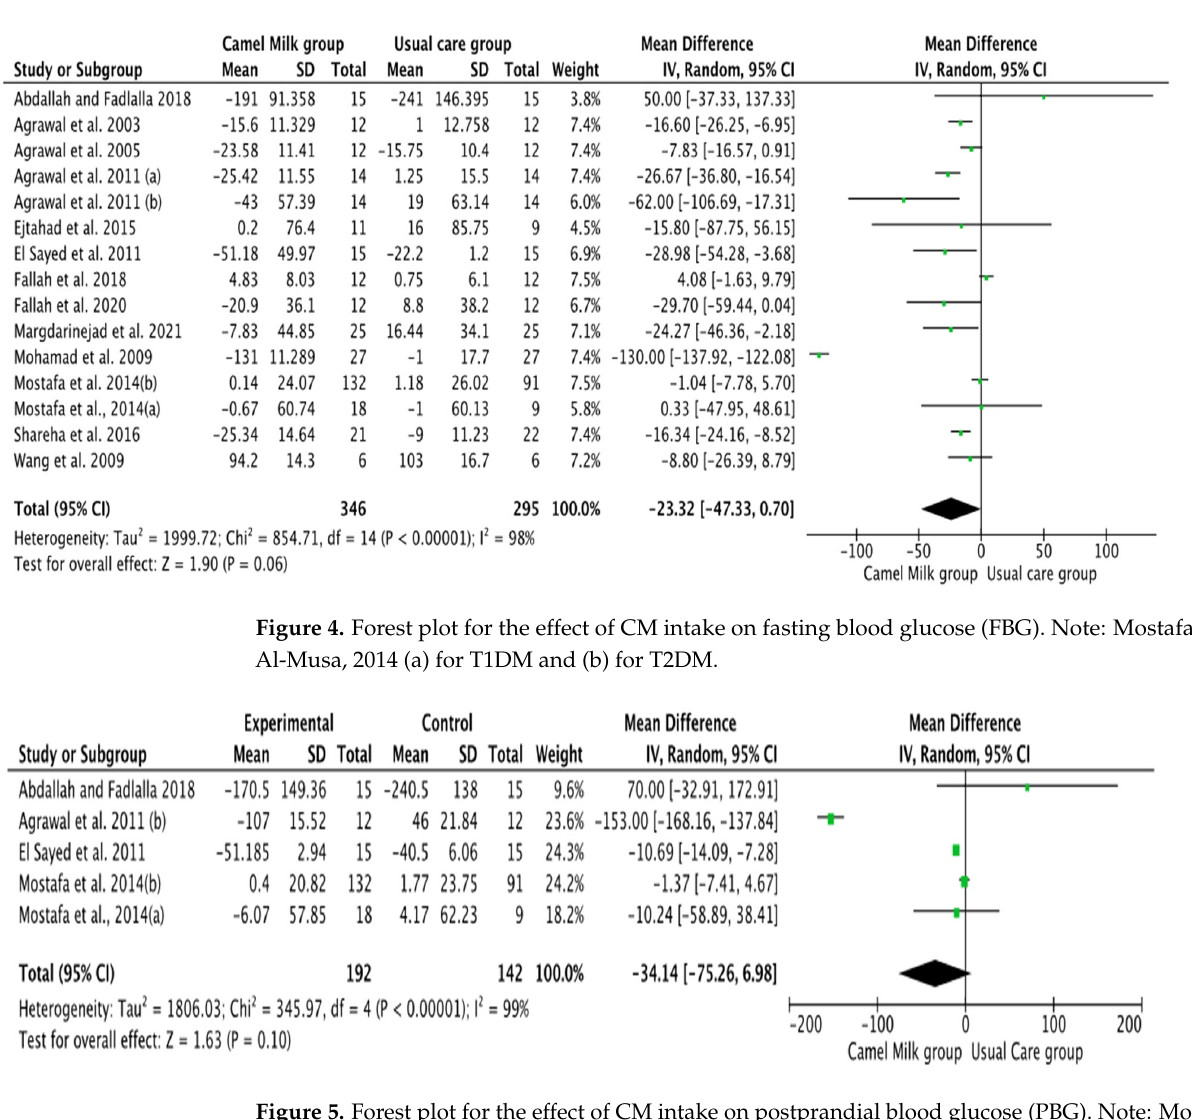
Figure 3. Forest plot for the effect of CM intake on insulin dose (ID). (a): difference between the two articles that are published by same author (Agrawal), same year.